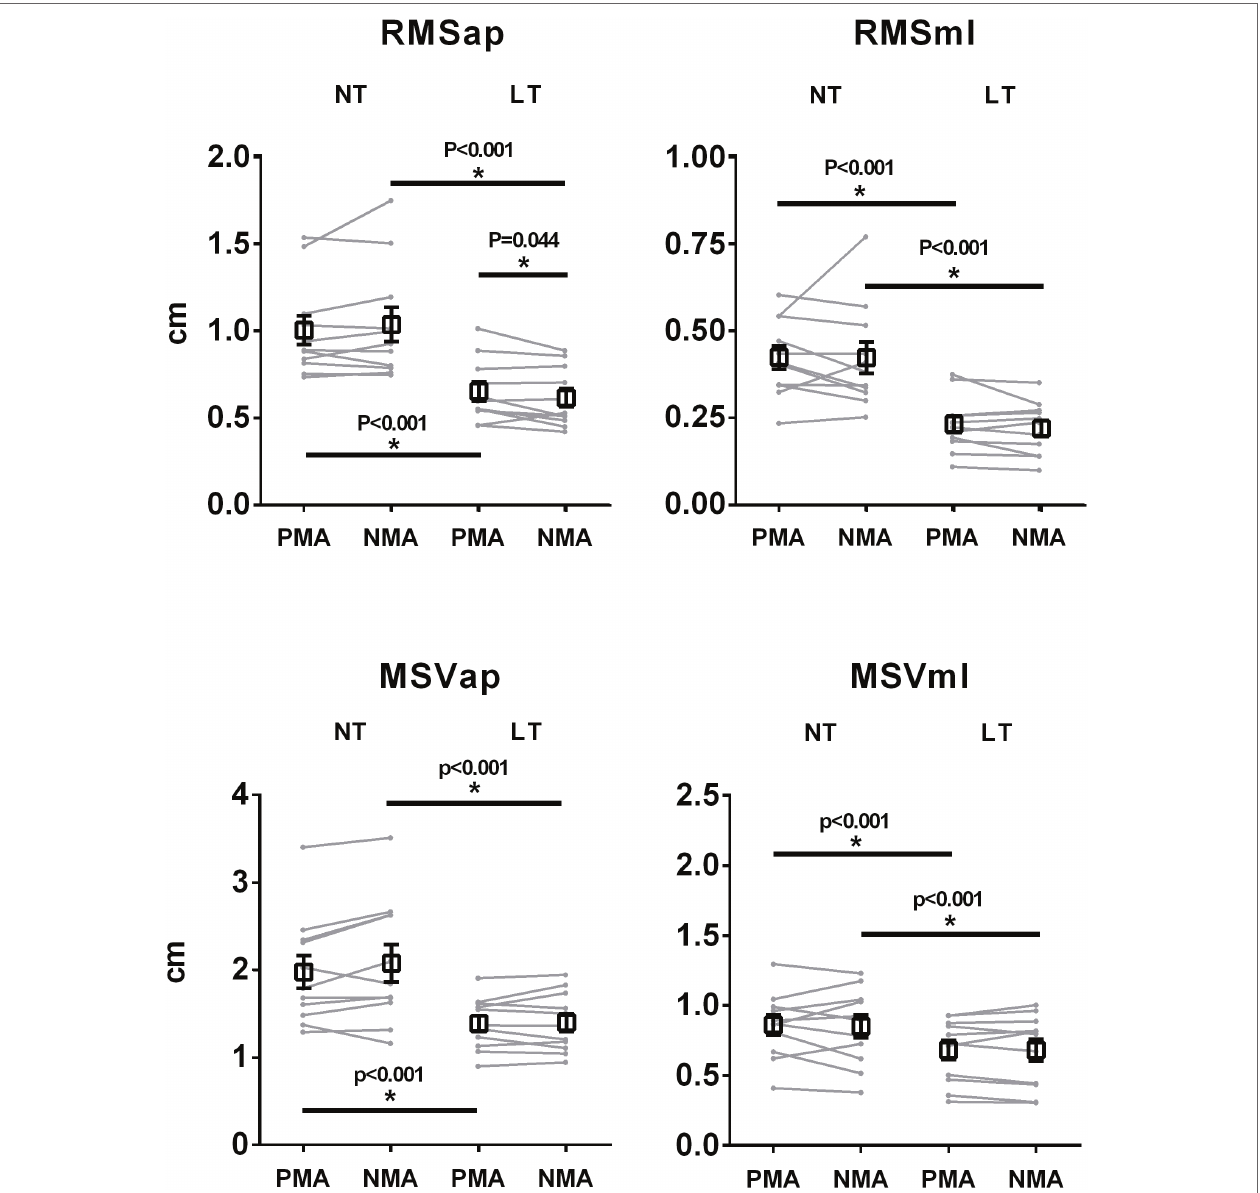
FIGURE 3 | Averaged (squares) and individual (gray lines) RMS and mean sway velocity (MSV) measurements (M ± SEM) computed from the COP signals in both AP and ML directions. * indicates significant ( p < 0.05) main effects for light touch, and significant interactions between light touch and finger